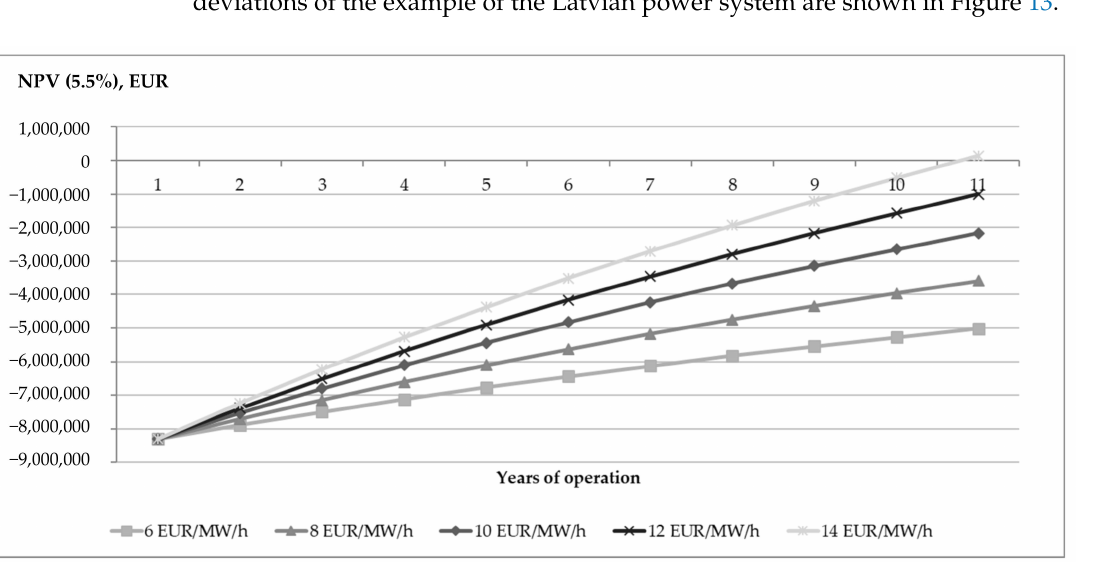
Figure 13. NPV curves of the BESS project for the example of Latvian power system at different FCR